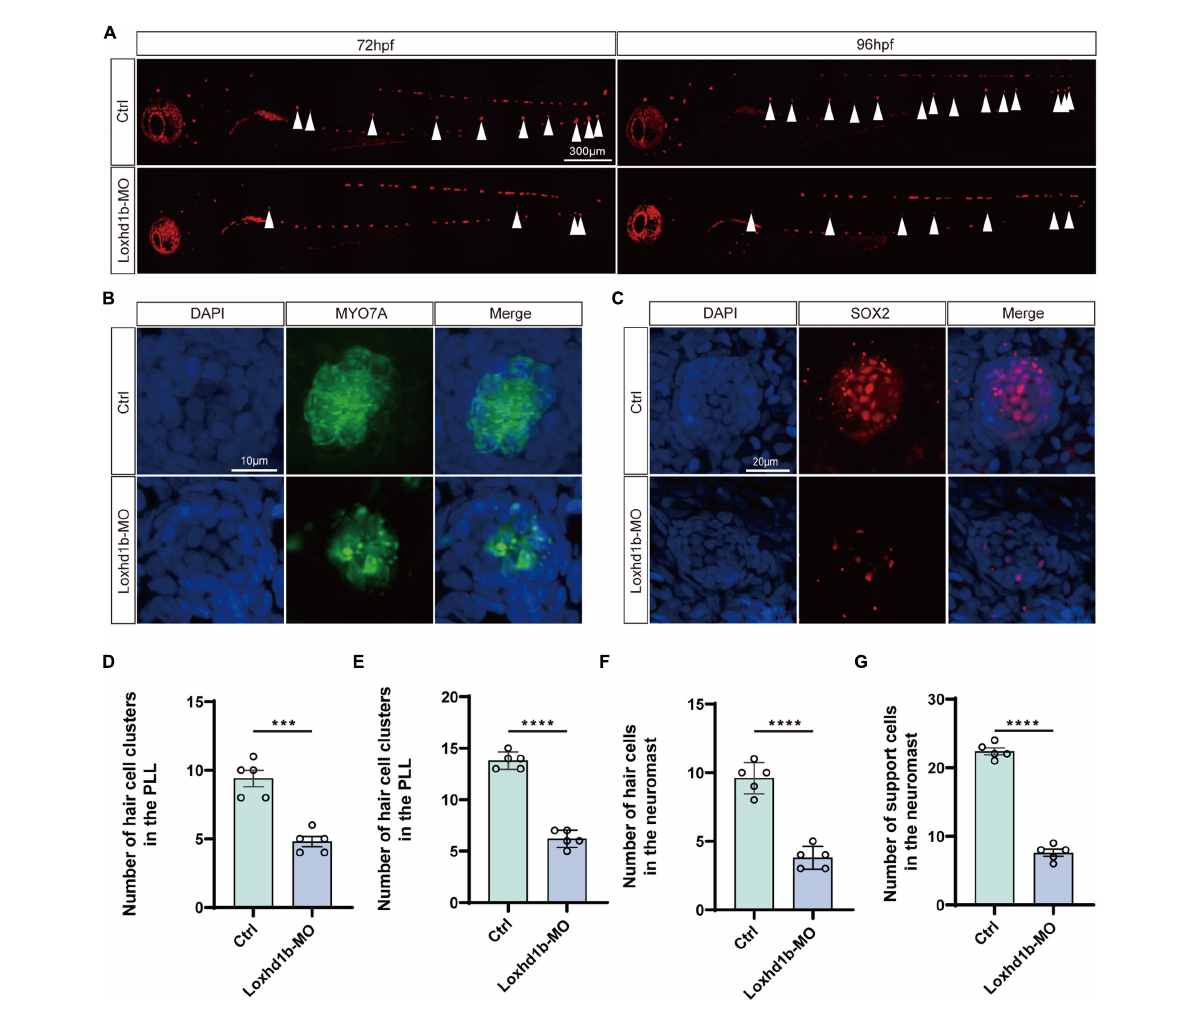
FIGURE3 Morphology and number of hair cells and support cells in Loxhd1b -knockdown and control zebrafish. (A) Reduced numbers of neuromast hair cells in Loxhd1b -morphant fish labeled by FM1-43FX at 72 and 96 hpf. The arrows point to the position of posterior lateral line neuromasts. Scale bar = 300 µ m. (B,C) Immunostaining of zebrafish lateral line hair cells and support cells at 72 hpf. Hair cells are stained with myosin-7a antibody and support cells were stained with SOX2 antibody. Scale bar = 10 and 20 µ m. (D–G) Statistical analysis of the hair cell clusters in control and Loxhd1b -morphan based on t -test. *** P < 0.001 and **** P <